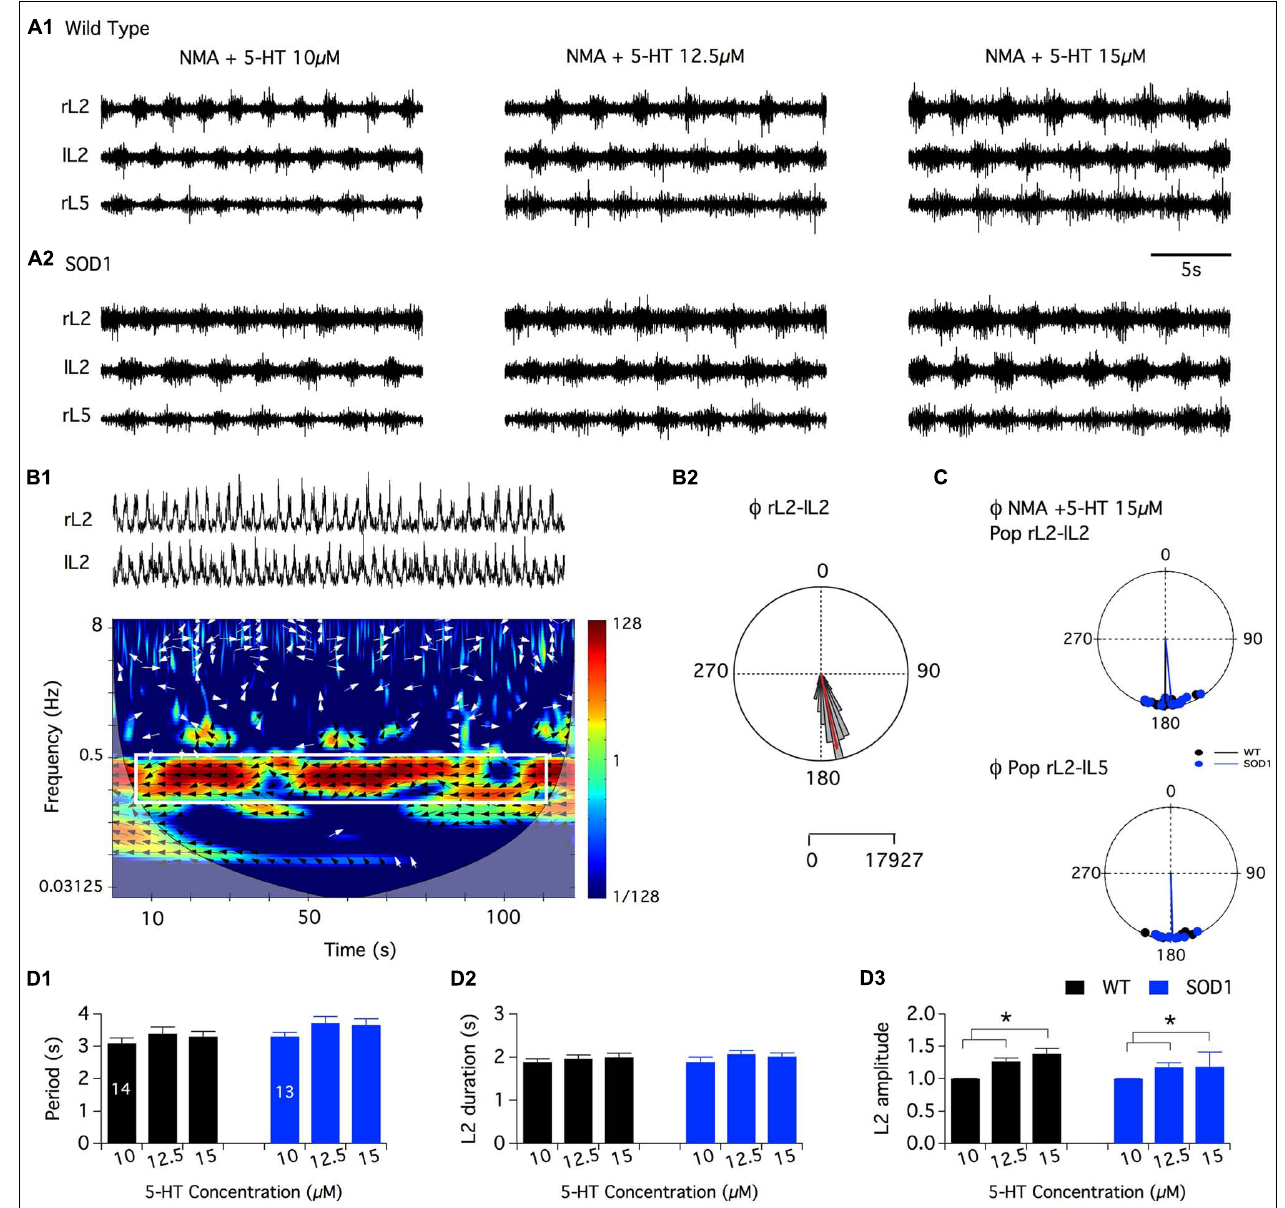
FIGURE 2 | Serotoninergic modulation of SOD1 G93A spinal locomotor networks. (A) Representative traces of the fictive locomotion recorded from the right and left lumbar 2 (rL2 and lL2) and right lumbar 5 (rL5) ventral roots in the presence of 16 μ m NMA and increasing concentrations of serotonin in WT (A1) and SOD1 (A2) newborn mice. (B) Mixed cross-coherence time frequency map (B1) computed from the high pass, rectified and low pass filtered traces presented in the upper panel recorded in the presence of 16 μ m NMA + 15 μ m 5-HT. The white box on the map represents the region of interest selected for further analysis. Black and white arrows indicate phase relationships with a left direction indicating an out of phase relationship. Polar graph (B2) of the phase ( (cid:2) ) relationships between rL2 and lL2 extracted from the graph in B1 . Calibration bars indicate the number of values in the largest histogram of repartition (5 ◦ bins). The evolution of the frequency